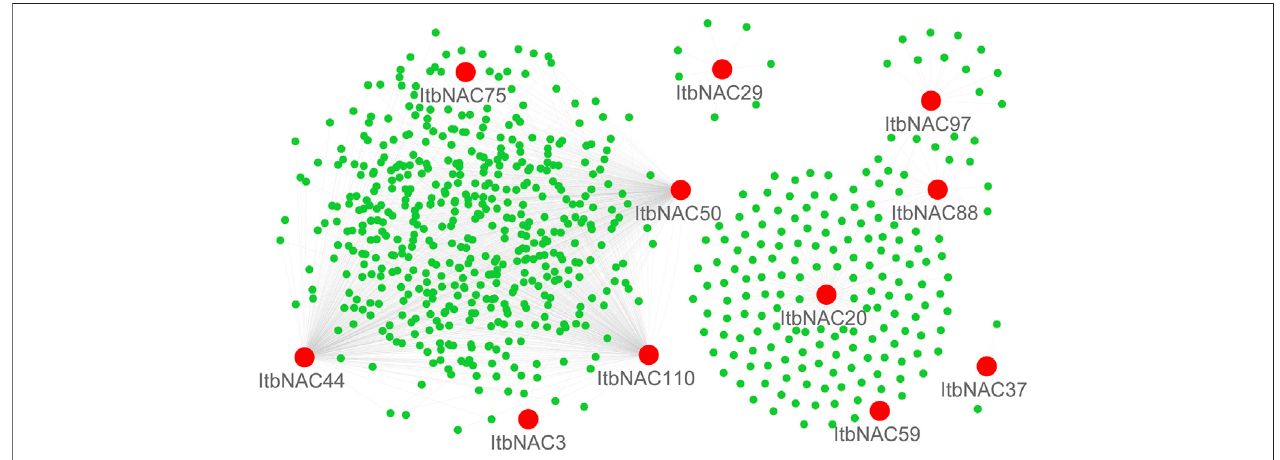
FIGURE 5 | Interaction networks of ItbNAC genes. The red circle indicates NAC family proteins, and green circle indicates other